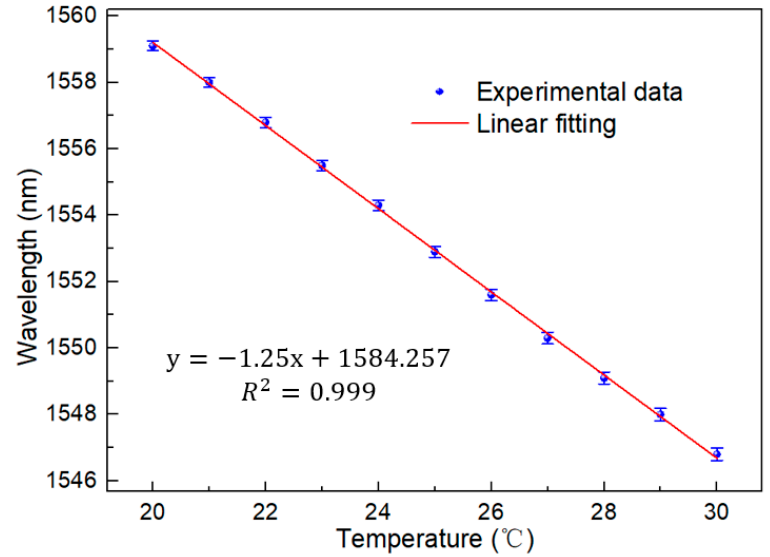
Figure 6. Linear fitting under BBS (20–30 ◦